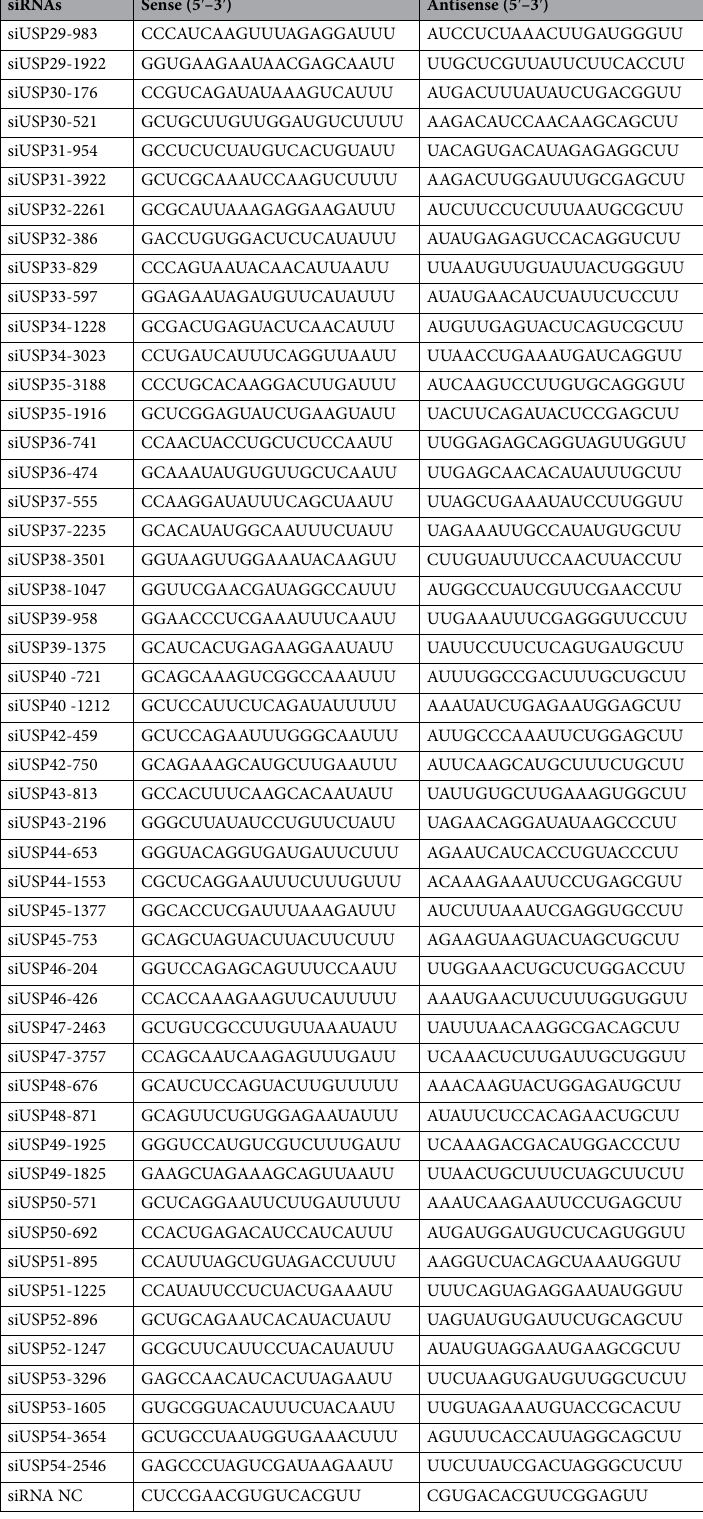
Table 1. Sequences of siRNAs targeting